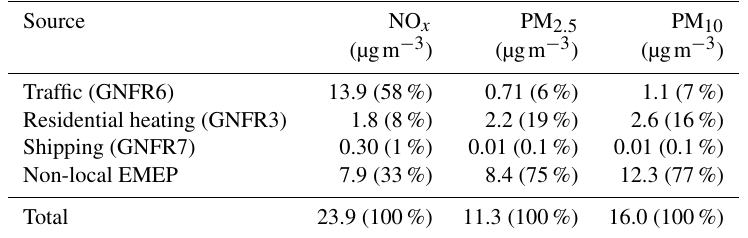
Table 2. Source contribution to all air quality stations in Europe calculated with uEMEP. The uEMEP local contributions are from primary emissions within a region of 2 × 2 EMEP grids ( ± 0 . 1 ◦ ) in both latitude and longitude. Non-local EMEP model contributions are all emissions from outside this region for the downscaled sources, as well as all other primary and precursor emission sources from within this region that are not